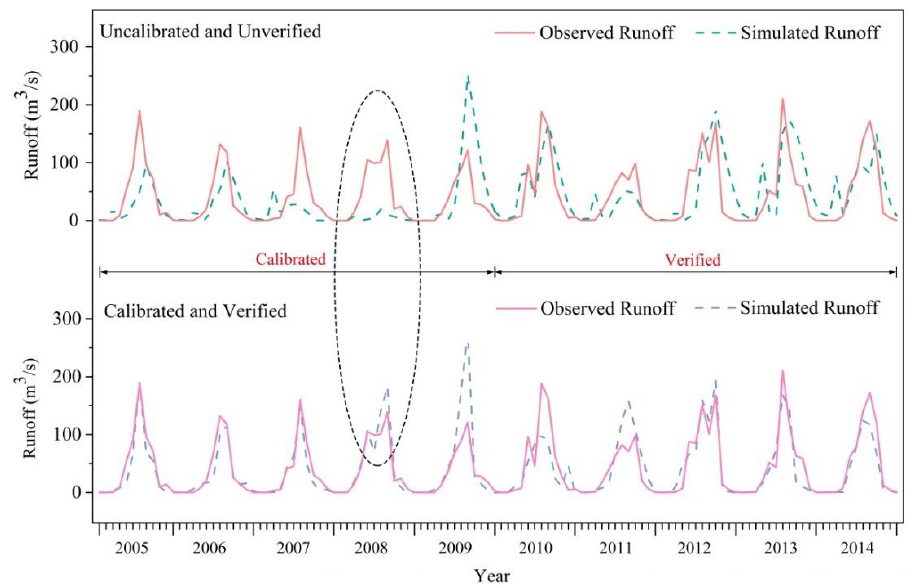
Figure 4. Observed and simulated monthly runoff during the calibration and validation periods of the study area. study